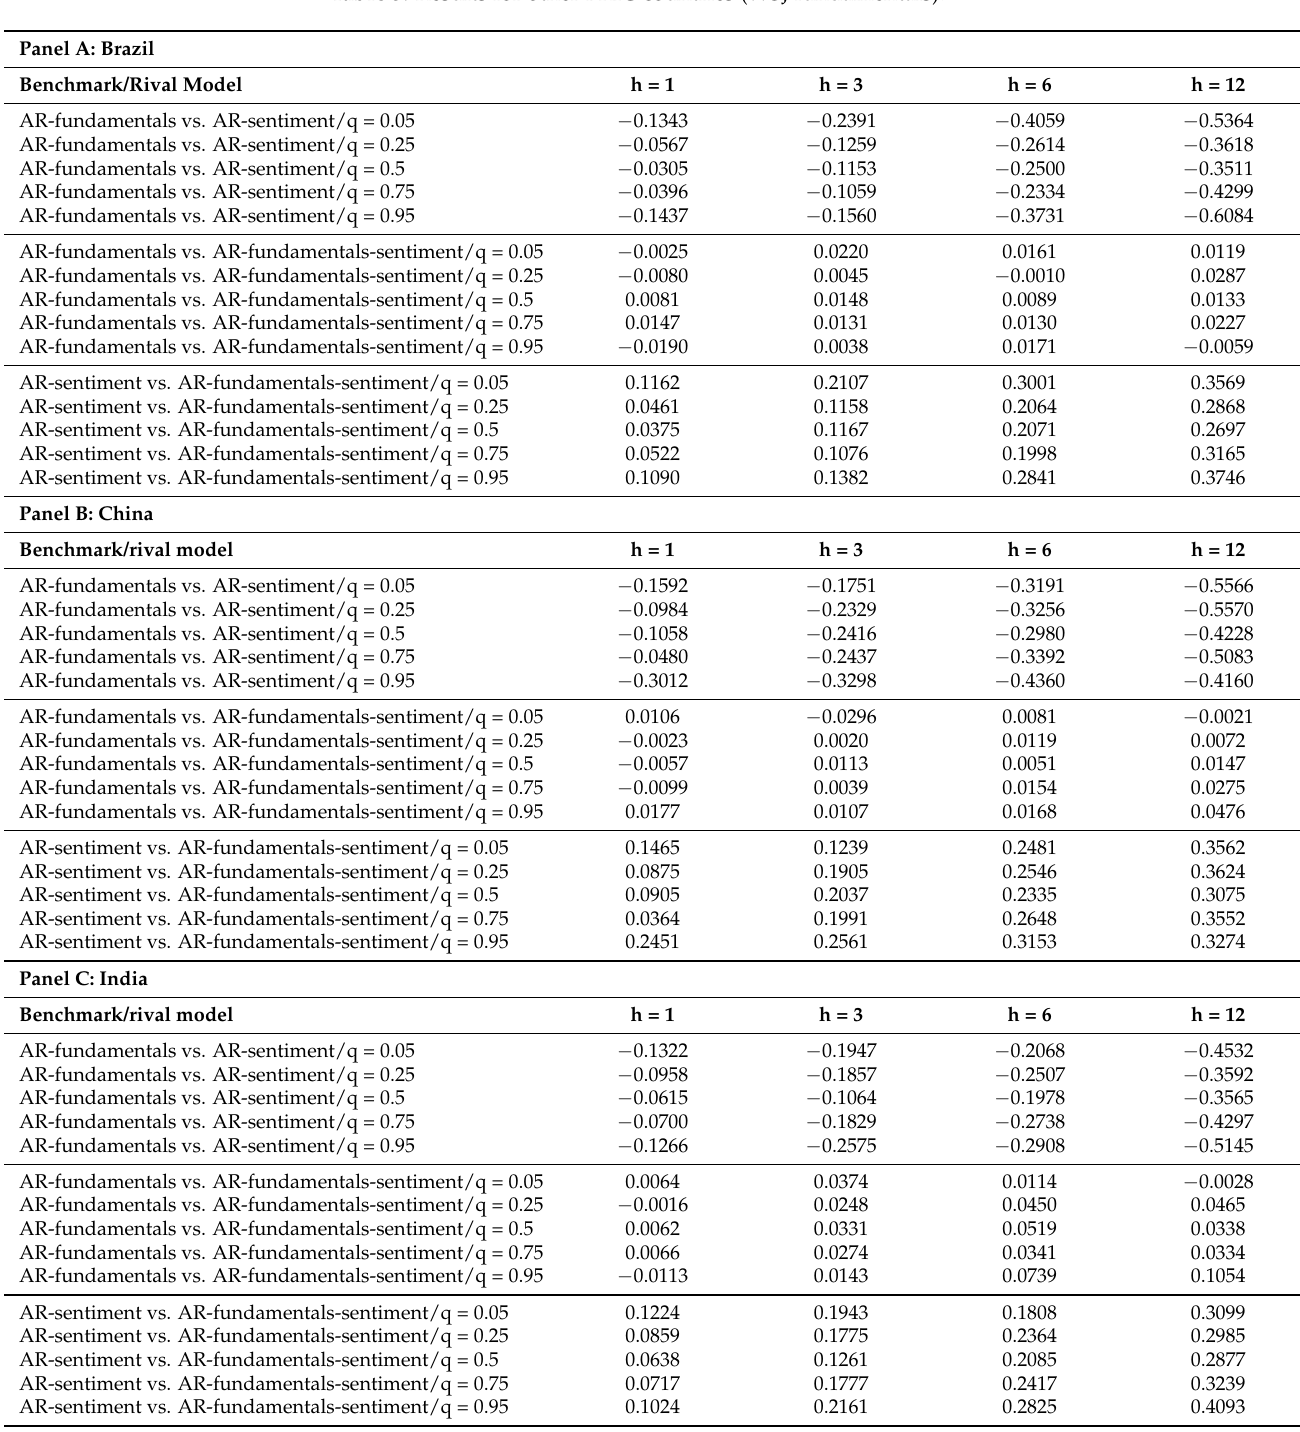
Table 5. Results for other BRIC countries (WSJ